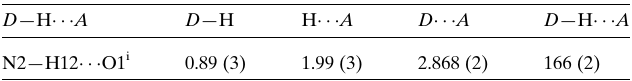
Table 1 Hydrogen-bond geometry (A˚ , (cid:3) ).